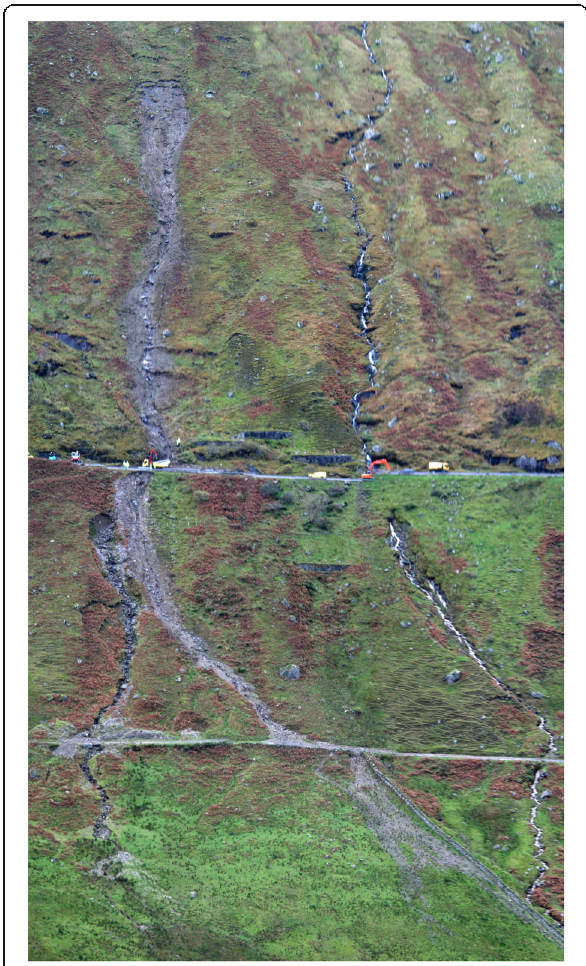
Fig. 2 View of the debris flows above and below the A83 on the approach to the Rest and be Thankful. The head scar is at approximately 370 m Above Ordnance Datum (AOD), the A83 at 240 m AOD and the Old Military Road (OMR) at 180 m